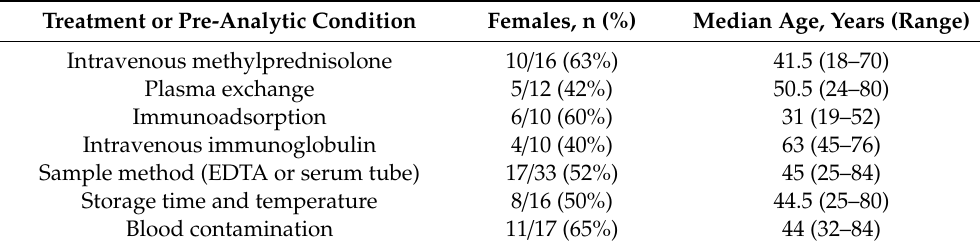
Table 1. Demographic data of prospective patients: treatment and different pre-analytical conditions. Percentage of females and age of patients treated with intravenous methylprednisolone, plasma exchange, immunoadsorption, and intravenous immunoglobulins were recorded. Percentage of females and age of patients whose samples were used to investigate pre-analytical conditions as storage of blood in EDTA and serum tubes, storage of CSF and serum samples for 14 days at room temperature or at 4 ◦ C, and contamination of cerebrospinal fluid (CSF) with 5000 and 20,000 erythrocytes / mL CSF. Patient age was depicted as median and